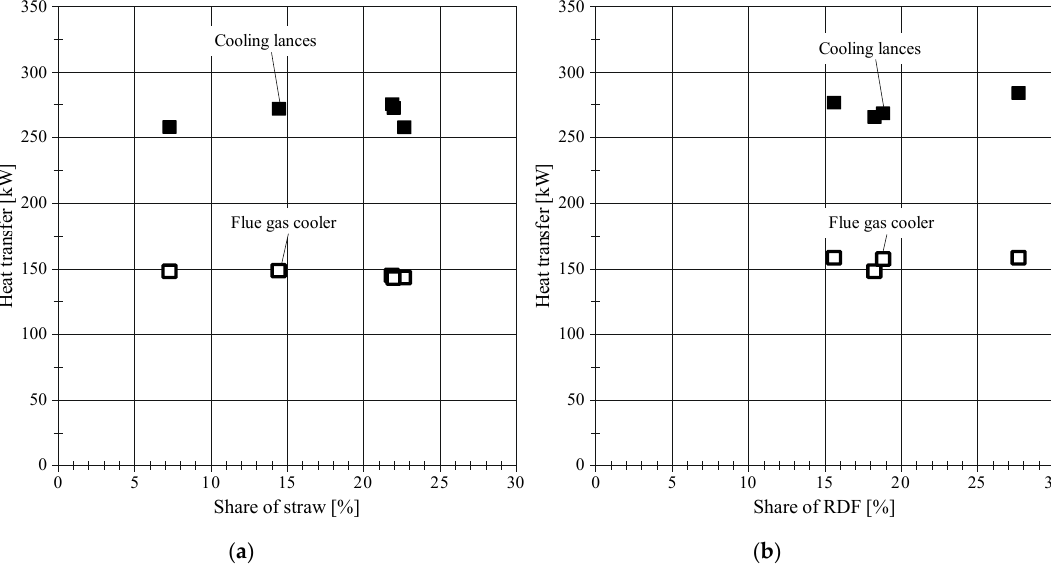
Figure 8. Heat transfer (similar load/flue gas flow rate): straw ( a ) and RDF ( b ).